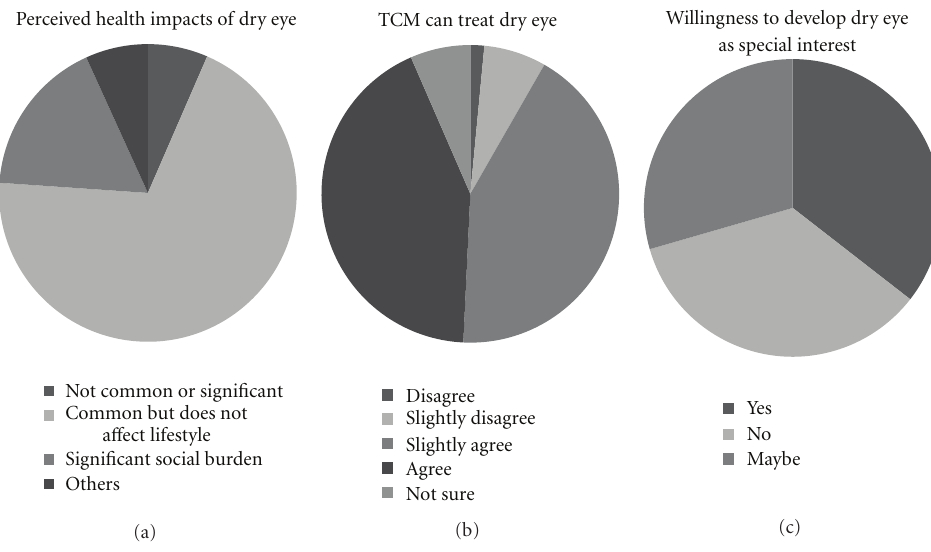
Figure 3: Attitude of TCM practitioners towards dry eye disease. Pie chart illustrating TCM practitioners’ perception of (a) dry eye disease, and (b) e ffi cacy of TCM in treatment of dry eye. Disagree: TCM is inappropriate to treat dry eye; slightly disagree: only some patients improve; slightly agree: most ( > 70%) patients show improvement; strongly agree: dry eyes can be symptomatically cured in most ( > 70%). (c) Pie chart showing the willingness of TCM practitioners to develop a special interest in treating dry